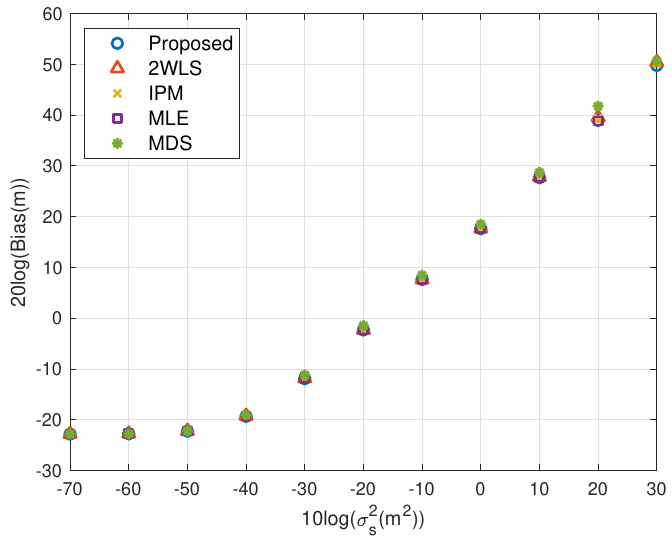
Figure 13. Bias performance as error level increasing (near source, 6 sensors).